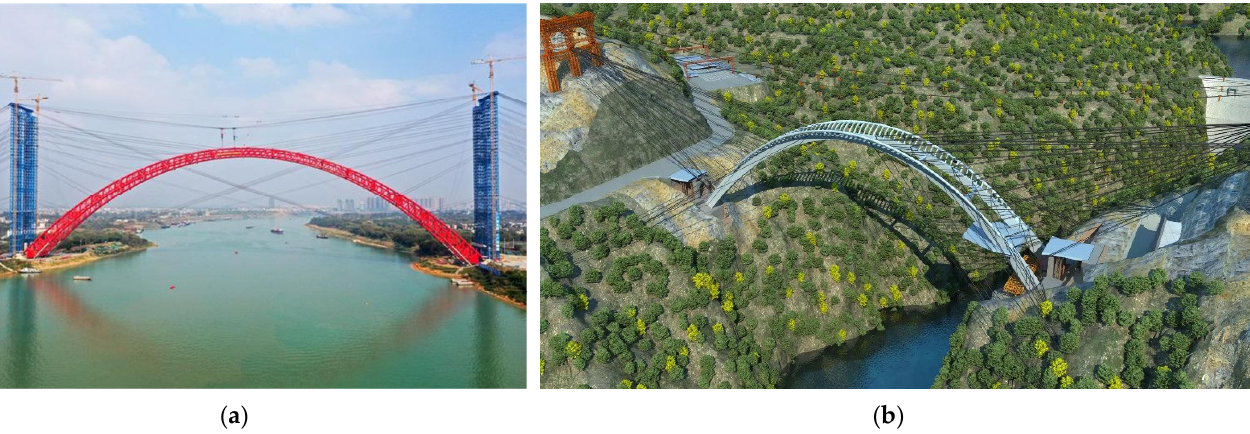
Figure 1. Cable lifting construction of large-span arch bridges: ( a ) Pingnan Third Bridge; ( b ) Jinghe Bridge.